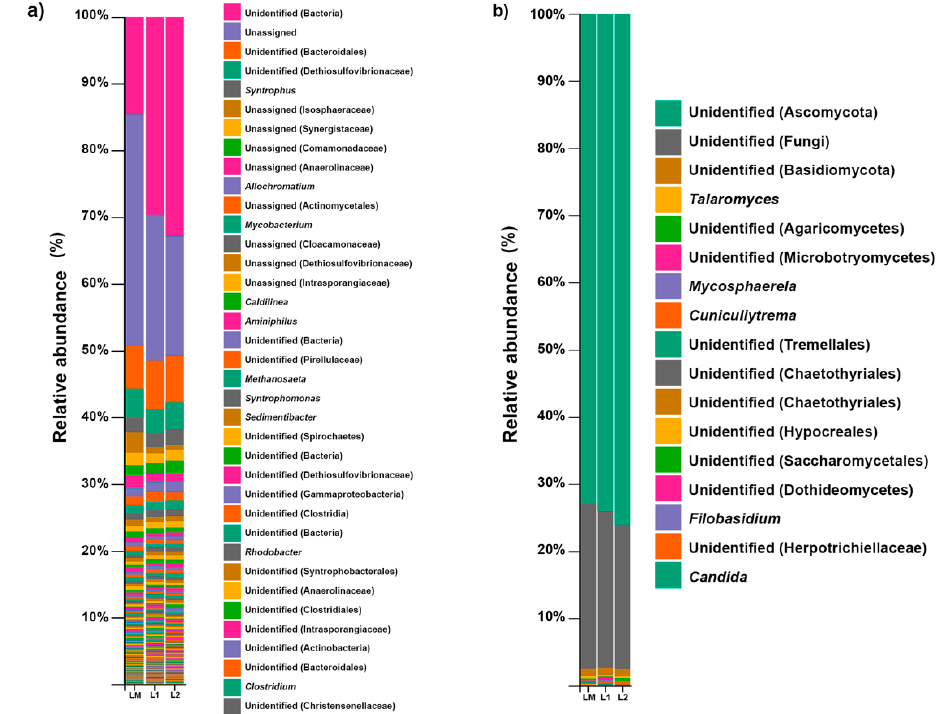
Figure 1. Percentage of relative abundance of the bacterial ( a ) and fungal ( b ) communities at the genus level, using Illumina MiSeq for the three samples. Sludge mix (LM), sludge sample 1 (L1), and sludge sample 2 (L2). 261